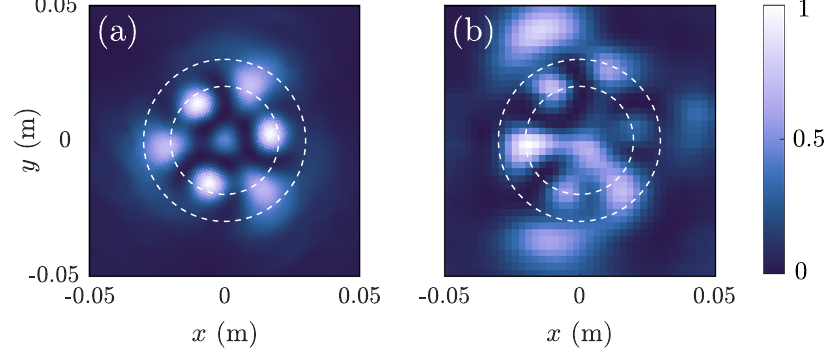
Fig. 5 Additional results at 63 kHz. Absolute Pressure ( ∣ P ∣ 2 ) of a FEM simulation and b Experimental results, evaluated under the same analysis and at the same plane as in Fig. 2, showing qualitative agreement of the acoustic mode shape in the fl uid. The dashed white circles show the positions of the inner and outer radii of the